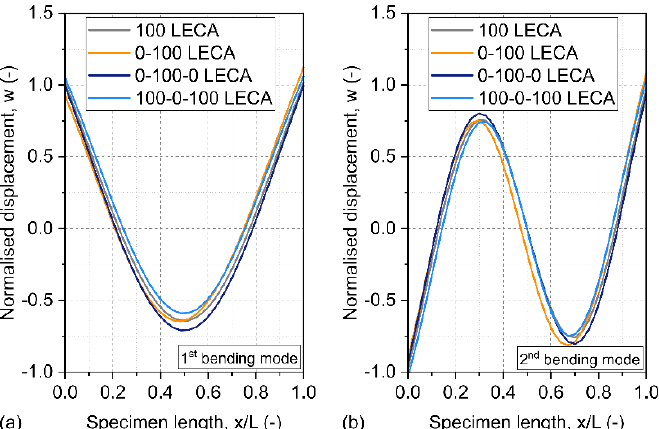
Figure 9. Modal analysis results for different GMF samples. Panel ( a ) shows the measured and fitted density functions, while panel ( b ) illustrates the resulting first and second bending mode shapes.